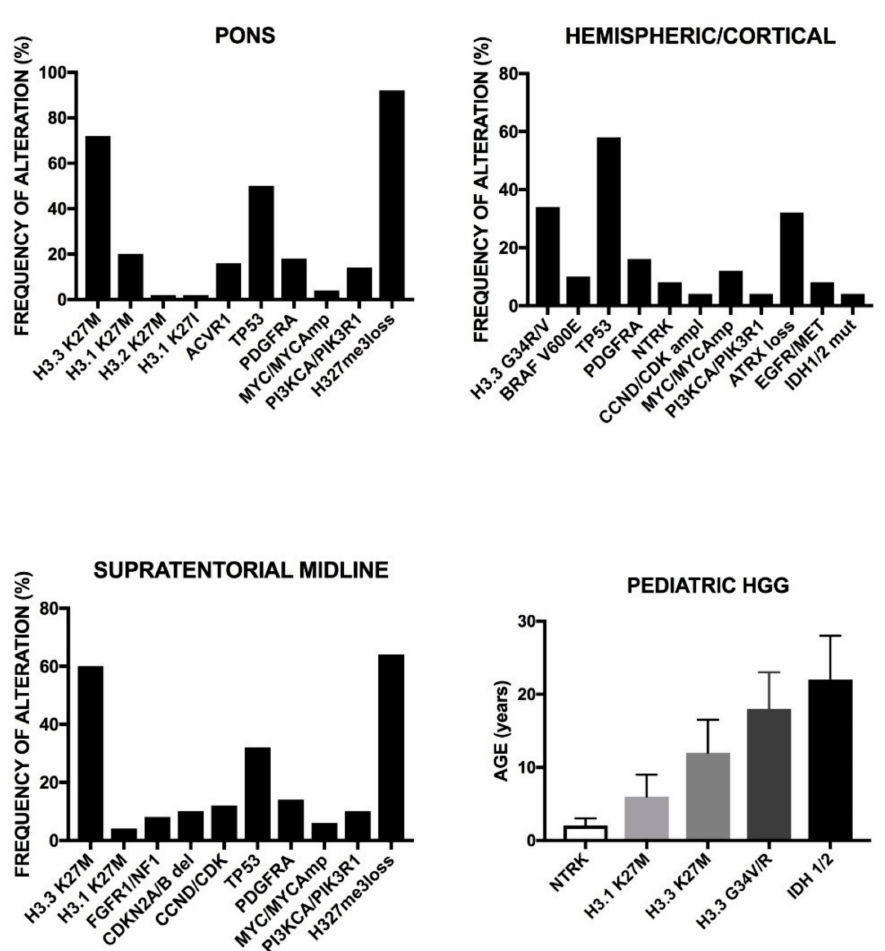
Figure 2. Genetic abnormalities of high-grade pediatric gliomas subdivided into three subtypes according to the site of origin in the CNS: pons ( A ), hemispheric/cortical ( B ), Supratentorial midline ( C ). Age of occurrence of mutations ( D ). Data are reported in refs.